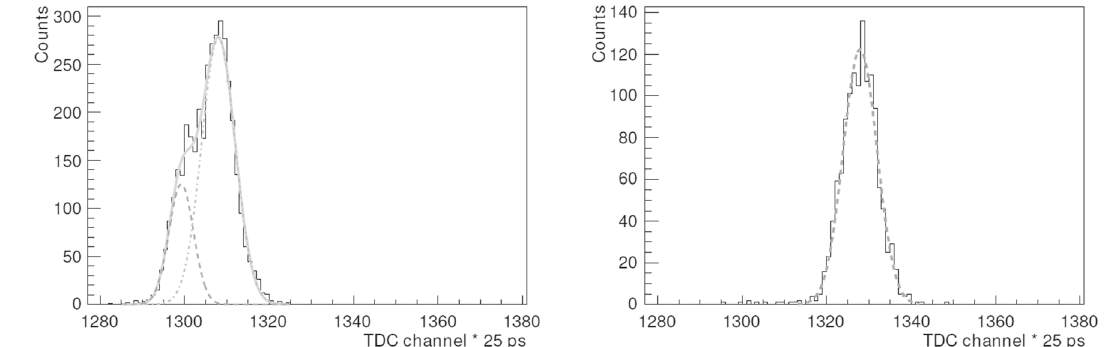
Fig. 4 Time-of-flight of fragments of Z/A with momentum of 13.9 GeV / c . Left: carbon ions shows double Gaussian structure due to two isotopes of carbon in the beam. Right: beryllium ions show single Gaussian distribution, indicating isotopic purity of the beryllium in the beam Fig. 5 Left: construction schematic of a PSD module. Right: front face of the PSD showing modules in green used for centrality determination. The modules marked with gray colour were not installed yet during taking at 40 A , 75 A and 150 A GeV /